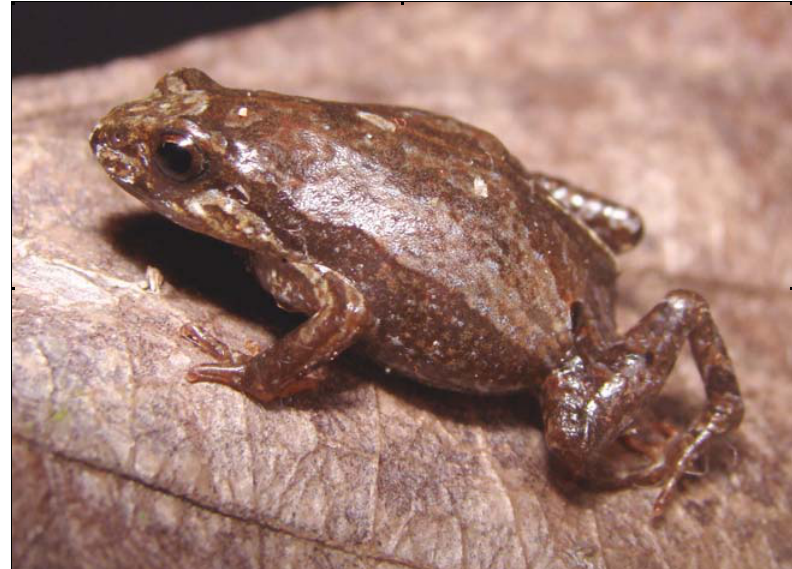
Figure 1. Adult male of Physalaemus rupestris (MZUFV 9039) from Serra Negra, municipality of Rio Preto, state of Minas Gerais, Brazil. Photo by Julia